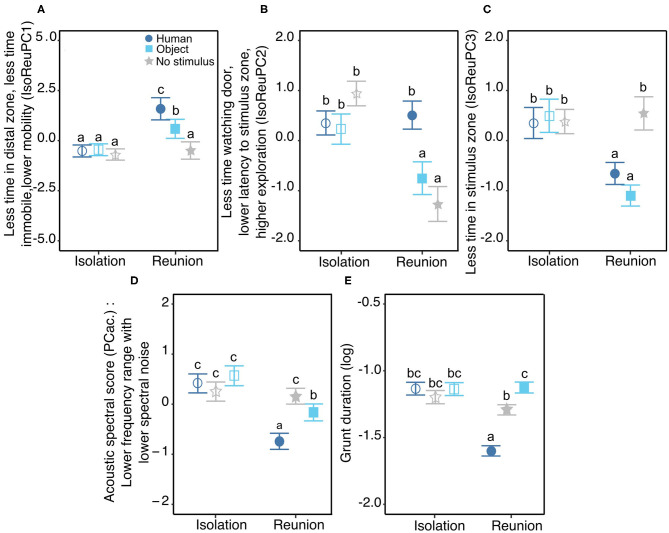
Behavioral (A–C) and vocal (D,E) responses to the Isolation/Reunion test. Mean (±se) of behavioral and acoustic scores, according to the stimulus (Human = dark blue circles, Object = light blue squares, No stimulus = gray stars), the phase of the test (Isolation = empty symbols or Reunion = filled symbols) and/or the day of the test (day 1, 2, or 3). (A–C) significant interaction between the type of reunion and the phase of the test for the three behavioral response scores IsoReuPC1, IsoReuPC2, IsoReuPC3, respectively. (D,E) significant interaction between the type of reunion and the phase of the test for the two acoustic scores: the acoustic spectral score (D) and the logarithm of grunt duration (E). Different letters show significantly different groups (p < 0.05). All model estimates, anova tables, and results of post hoc tests are available in Supplementary Tables 4–6. Description of each behavioral and each acoustic parameter depending on experimental conditions is available in Supplementary Tables 2, 3, respectively.